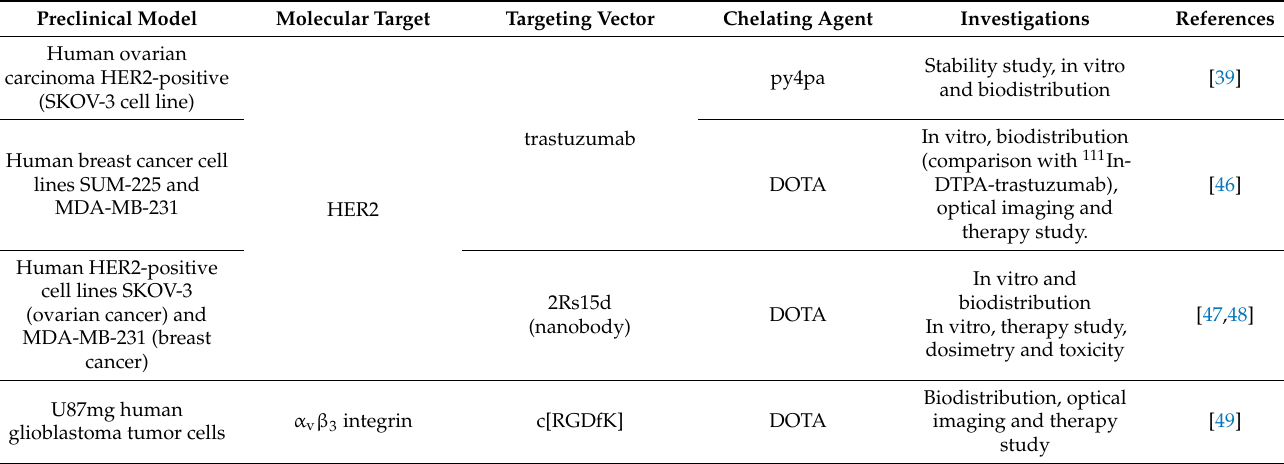
Table 1. Reported 225 Ac preclinical studies involving an identified pathology model (non-exhaustive list). Preclinical Model